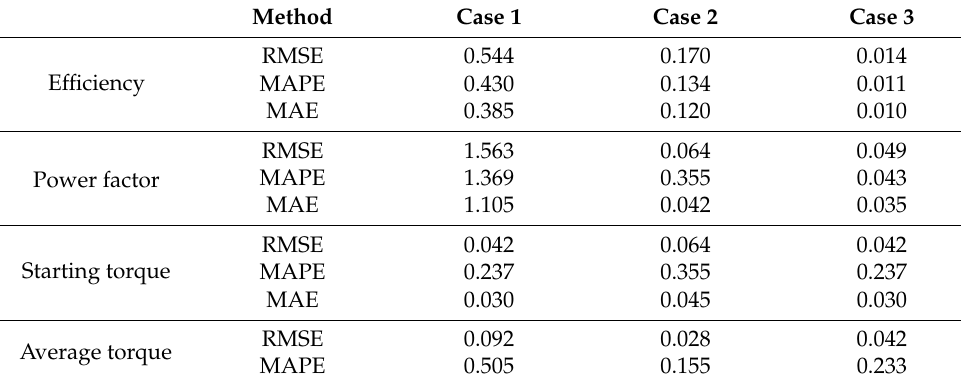
Table 8. Verification of prediction accuracy through RMSE, MAPE, and MAE.